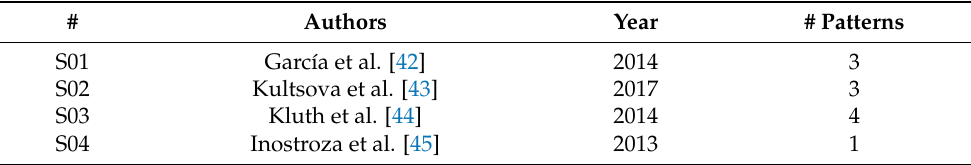
Table 5. Selected